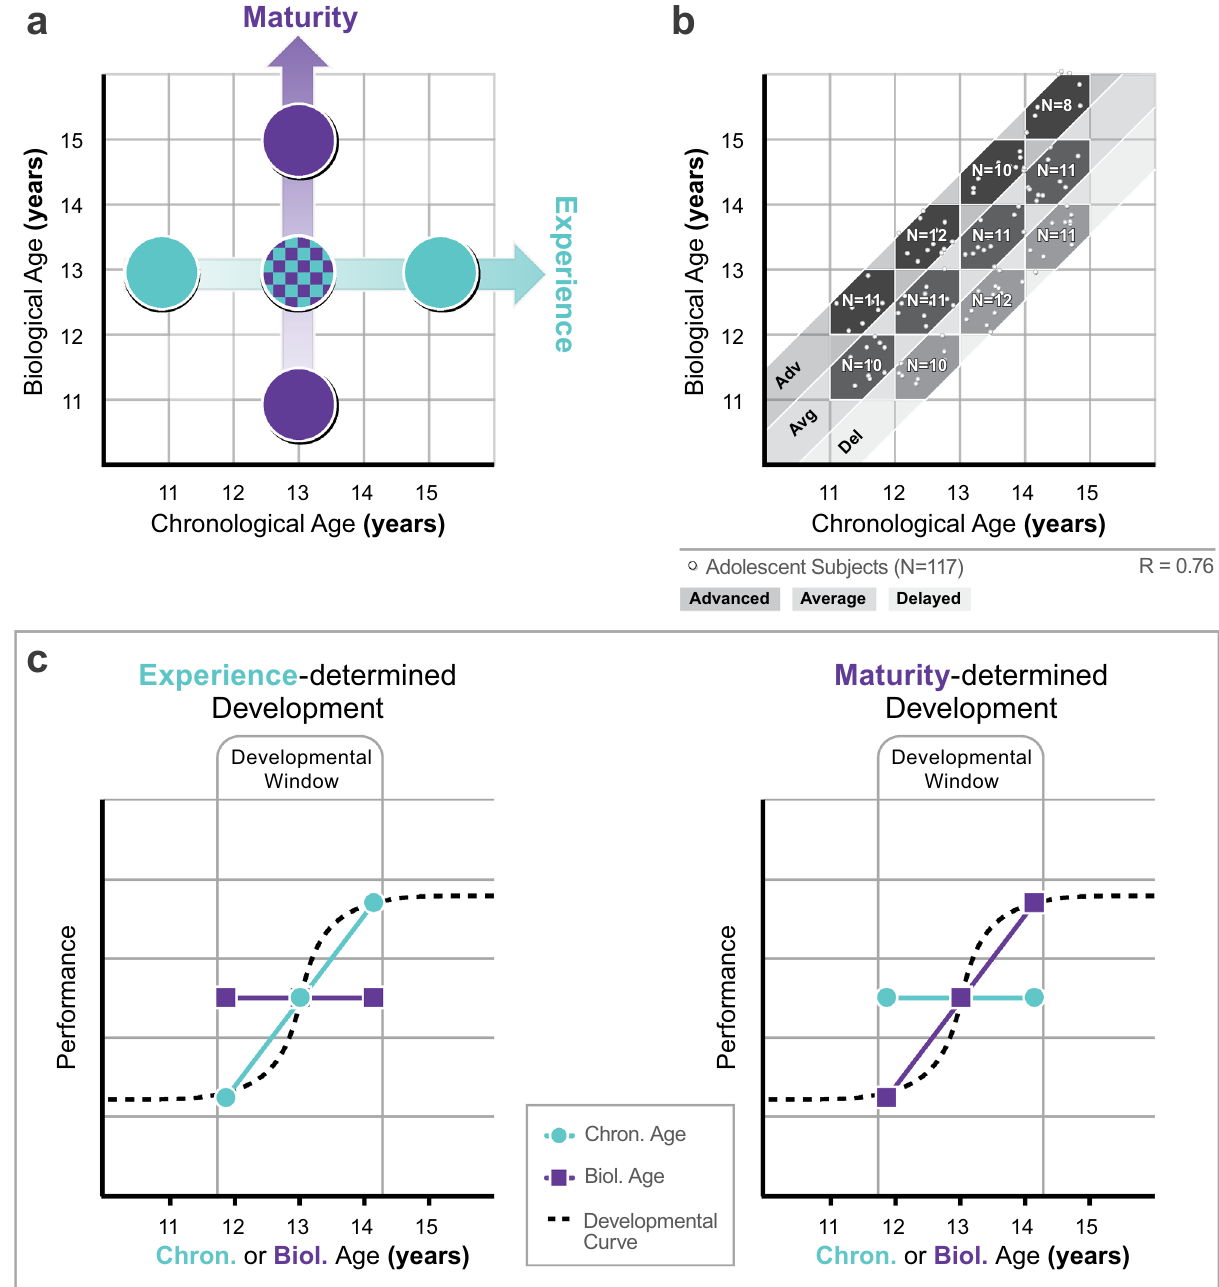
Figure 1. Dissociating the effects of experience and maturation in adolescent development. ( a ) Comparing cognitive performance of participants with different biological age (BA) within the same chronological age- group can reveal the impact of biological age (vertical ‘Maturity’ axis) independently of chronological age (CA), while the comparison of different CA participants with the same maturity level reveals the impact of CA independently of maturation (horizontal “Experience” axis). ( b ) In order to dissociate the impact of BA and CA we identified cohorts of participants with advanced, average, and delayed maturity using bone age assessment within 11 and 15 years of CA. Each 1-year-wide hexagonal bin consisted of 8–12 subjects (white dots within the bins). c Predictions: Vertical axes indicate development in any cognitive domain. Horizontal axes express age (CA or BA). Important developmental events occur within a “Developmental window” where performance radically changes approaching adult levels. In the extreme case of experience-determined development, we expect to see a significant improvement of performance between different CA groups (matched for BA), while performance will remain the same across different BA groups (matched for CA). In the other extreme case where development is solely maturity-dependent, we expect improvement across different BA groups, and the lack of change across different CA groups. The final version of the figure was generated by Adobe Illustrator CC 23.02.2.